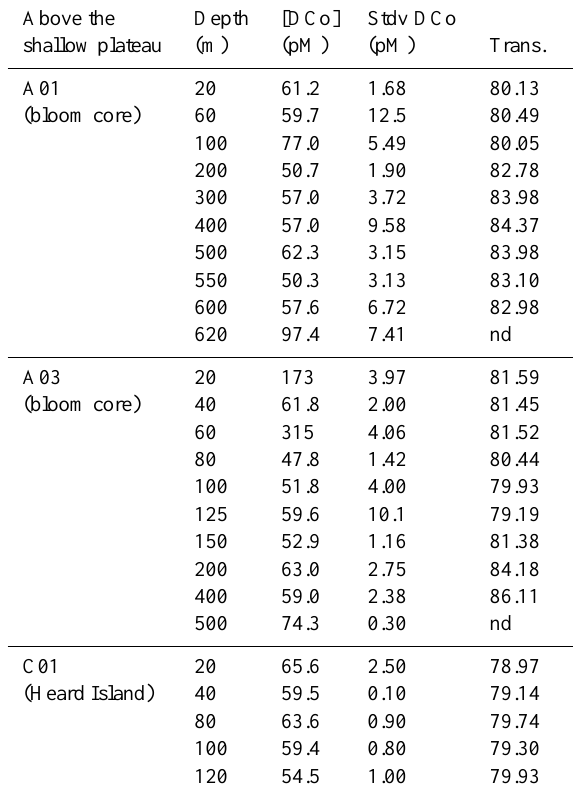
Table 1. Dissolved cobalt concentrations ([DCo]) and transmissom- etry (Trans.) obtained in the Indian sector of the Southern Ocean during the KEOPS cruise in 2005. Errors on the [DCo] (Stdv DCo) were calculated as standard deviation of triplicate measurements of the same